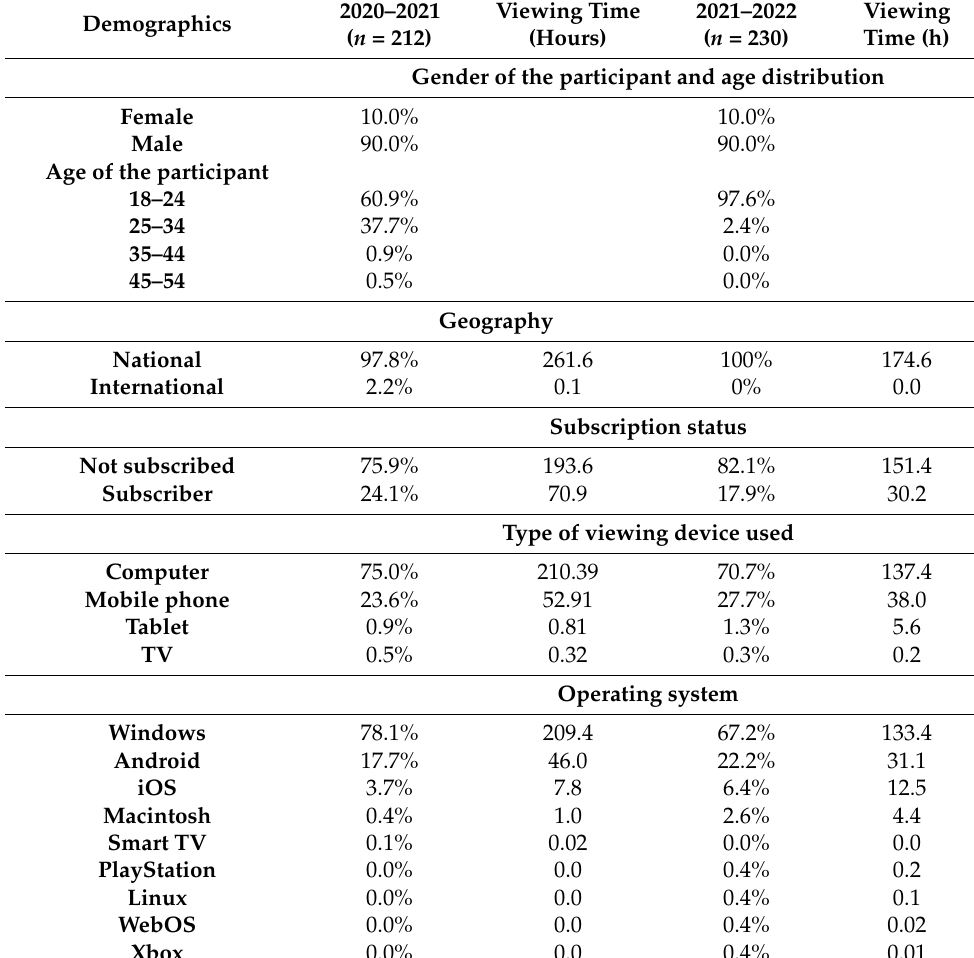
Table 1. Demographic information of mechanical engineering students who participated in the